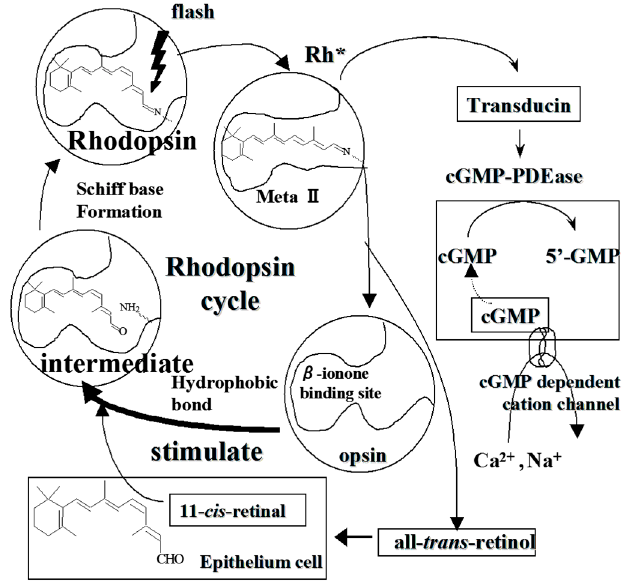
Figure 2. Schematic diagram of rhodopsin regeneration by anthocyanin.